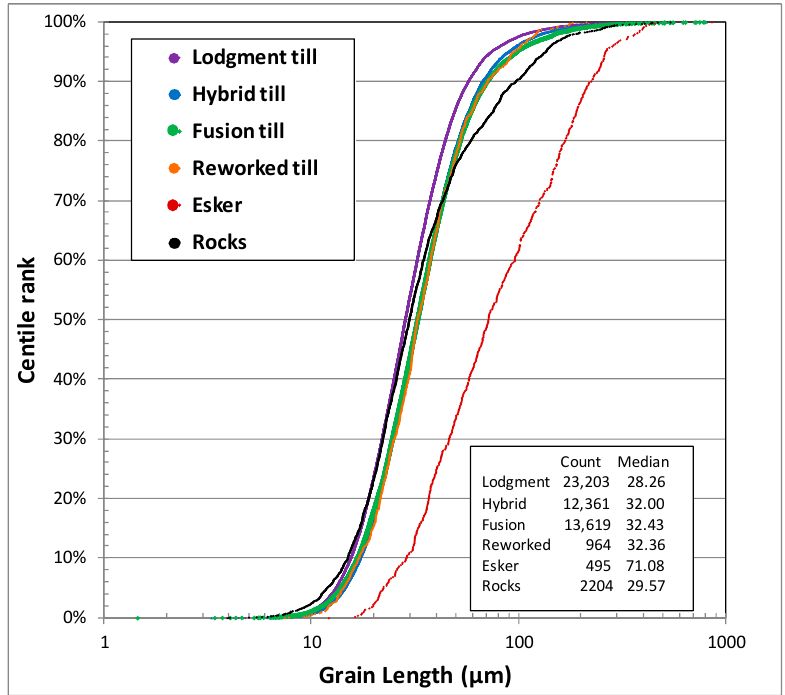
Figure 4. Gold grain size cumulative distribution plots according to sediments types. All samples were collected with a hand shovel by the same crew and sediment type is considered as properly classified. It can be noted that gold grains from lodgment tills are slightly finer than other types of sediment. Other glacial sediments that underwent contact with melt water, such as hybrid, fusion and reworked tills, are slightly coarser than those from lodgment tills, suggesting limited elutriation of the finest particles. Inversely, grains recovered from eskers or fluvioglacial sediments are distinctively coarser, suggestive of severe elutriation of fine grains. The black curve is for grains recovered from mineralized rocks though various metallurgical tests. Minute grains as well as grains larger than 40 µm are overrepresented compared to till, likely due to bias induced by the tests. However, the median grain size in rock remains similar to the one in the lodgment till.